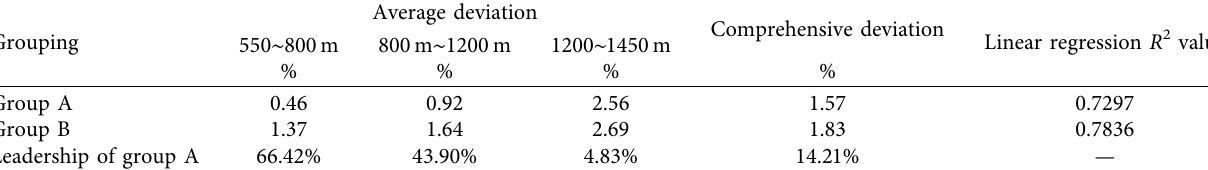
Table 2: Statistics of deep tunnel simulation advantages of the fluid structure coupling model (data source: collected by the study).